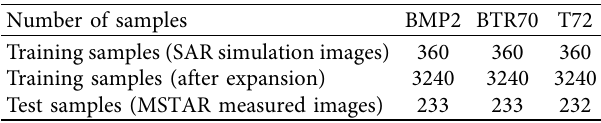
Table 7: Training and test samples used in nonhomologous target recognition experiments.